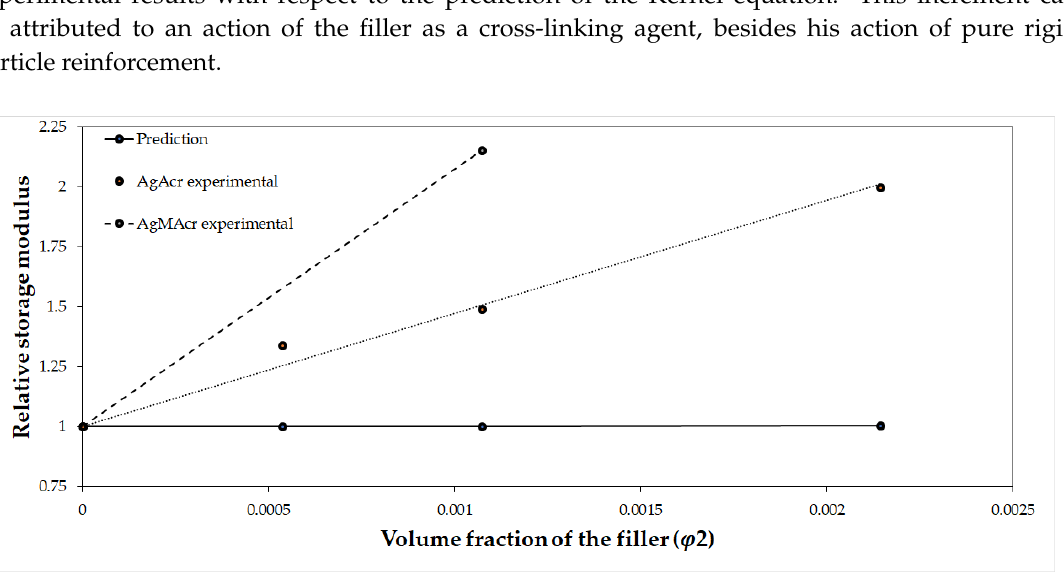
Figure 6. Relative storage modulus as a function of AgNPs volume fraction. A comparison between predicted and experimental values for the AgAcr filled series.